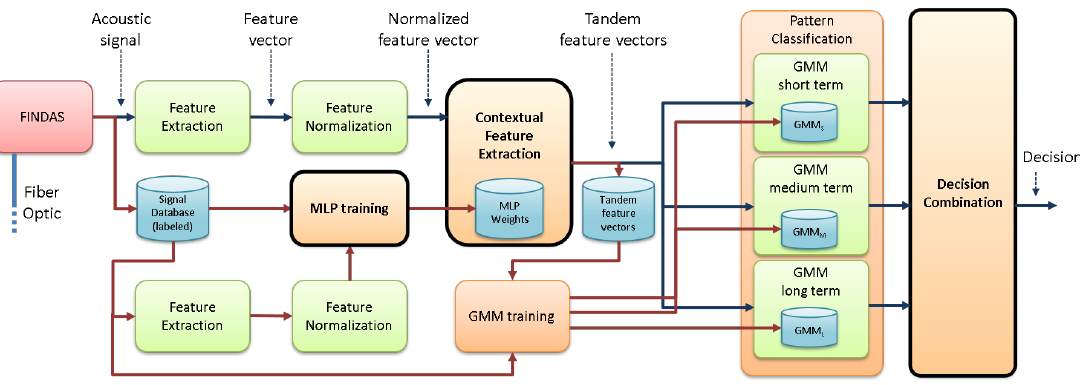
Figure 2. Novel pipeline integrity threat detection system architecture. Modules in bold typeface are the new ones with respect to